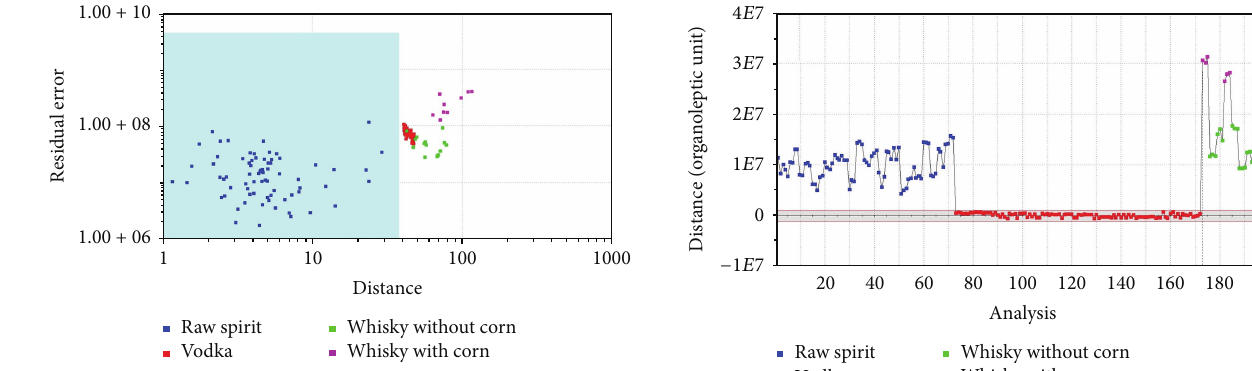
Figure 6: SIMCA analysis for vodkas, whiskies, and raw spirits: raw spirit, reference group.